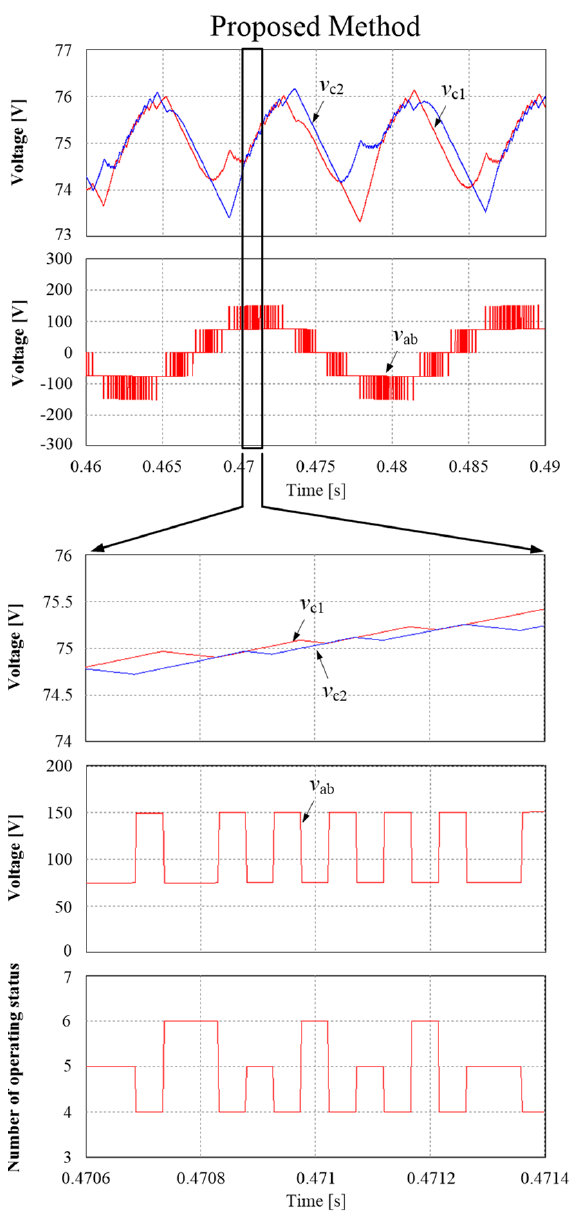
Figure 4. Simulation waveforms of proposed MPC method during period with converter voltage v ab between V dc /2 and V dc .